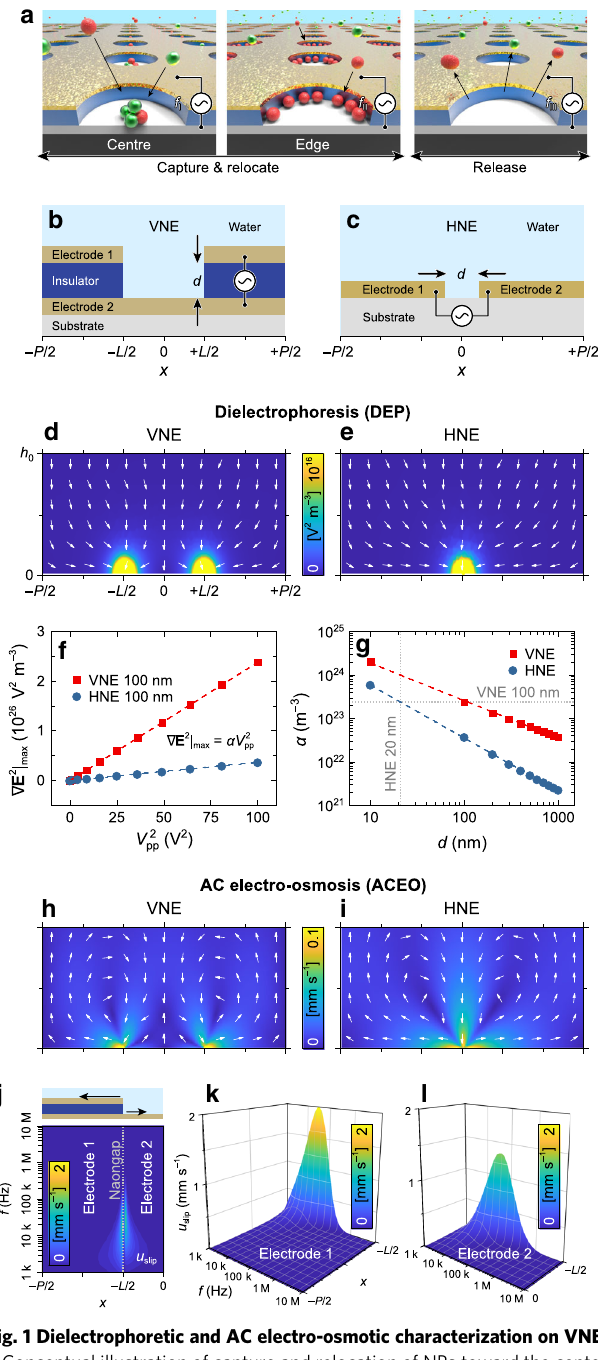
Fig. 1 Dielectrophoretic and AC electro-osmotic characterization on VNE. a Conceptual illustration of capture and relocation of NPs toward the center (left) and edge of VNE (middle) and their release (right). b , c Schematic of the VNE ( b ) and HNE ( c ). d , e Calculated distribution of ∇ E 2 on VNE ( d ) and HNE ( e ) with a gap distance of d = 100 nm under V pp = 1 V ( h 0 = 10 μ m). f , g Calculated ∇ E 2 | max on VNE (red square) and HNE (blue circle) as a function of V 2 pp ( f ), and its corresponding α as a function of d ( g ). h , i Calculated distribution of ACEO fl ow on VNE ( h ) and HNE ( i ) with a gap distance of d = 100 nm under V pp = 1 V and f = 1 kHz. j – l Calculated u d = 100 nm) as a slip distribution at the electrode surfaces of VNE ( function of f ( j , V pp = 1 V) with the schematic of u slip (inset in j ) and 3D illustrations of u slip on electrode 1 ( k , top electrode) and 2 ( l , bottom